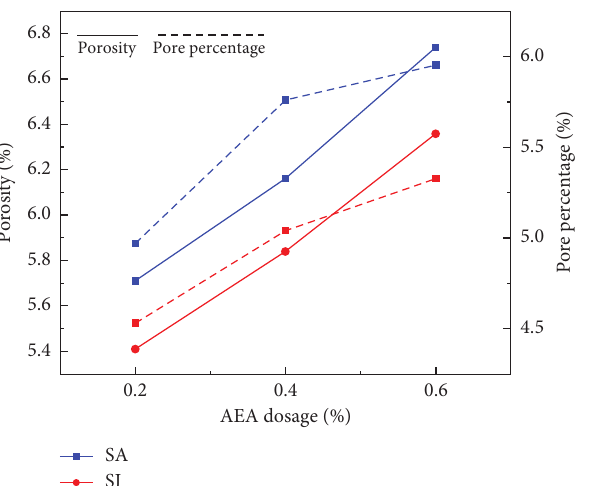
Figure 6: Changes of porosity and pore percentage with AEA content.